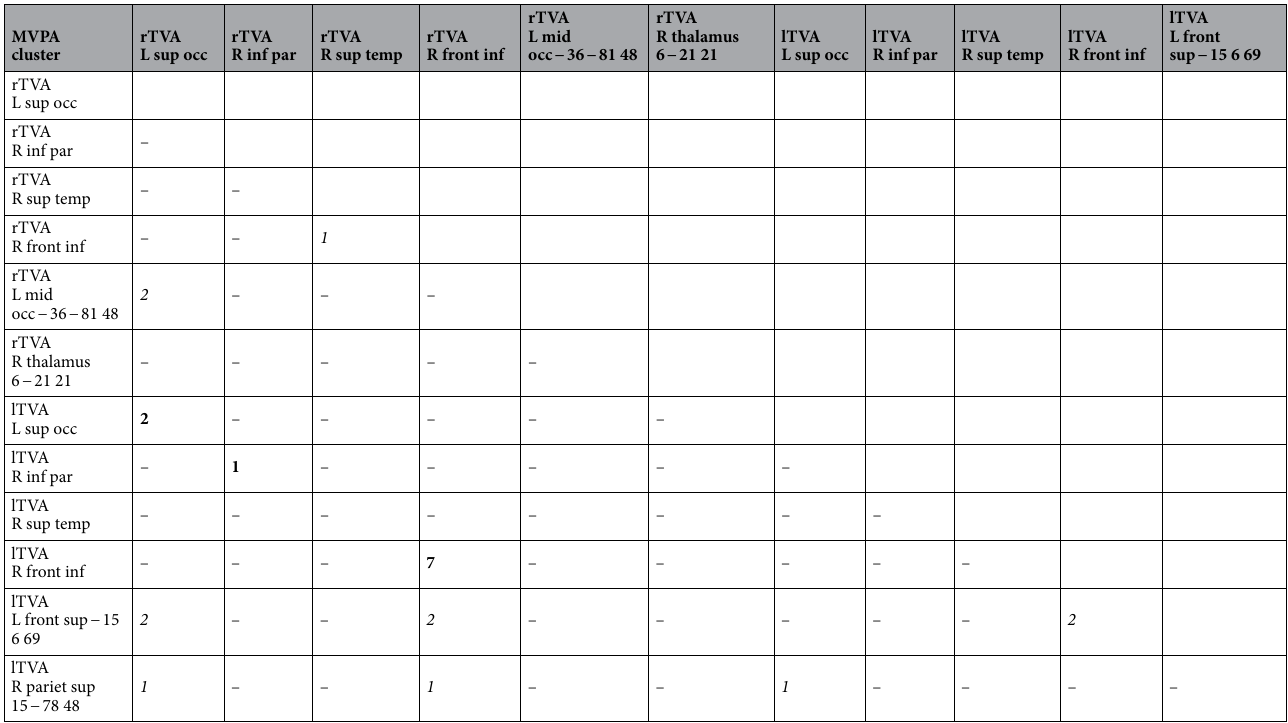
and face processing systems. Whereas for the TVAs a largely convergent pattern of clusters was observed, among others in the occipital gyrus and bilateral insulae, the patterns for the FFAs were mainly divergent and yielded only one common region in the right supramarginal gyrus extending into the inferior parietal gyrus. Moreover, we identified brain areas with RSFC patterns supramodally reflecting preferential responses to both, voices and faces. One area in the anterior rostral mediofrontal cortex (arMFC) displayed a maximum of